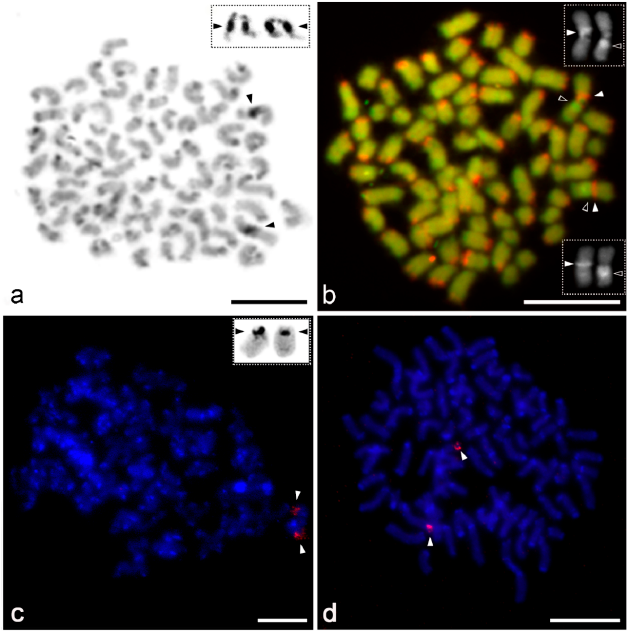
Figure 5. Male chromosomes of Charinus species after chromosome banding techniques ( a , b ) or 18S rDNA FISH ( c , d ). ( a , b , d ) Mitotic metaphase; ( c ) meiotic prophase I, early diplotene. ( a–c ) C. neocal- edonicus. ( a ) C-banding (Giemsa-stained). Note a prominent (peri)centromeric block of constitutive heterochromatin on chromosomes of a large chromosome pair (arrowheads). Inset depicts the same chromosome pair from C-banded meiotic metaphase II pointing to its acrocentric morphology. ( b ) Fluorescent banding with two fluorochromes, GC-specific CMA 3 and AT-specific DAPI. For better contrast, pictures were pseudocolored in red for CMA 3 and green for DAPI. Note a large chromo- some pair with a huge block of (peri)centromeric heterochromatin formed by two segments differ- ing in affinity to applied fluorochromes; CMA 3+ band (full arrow) vs. DAPI + band (empty arrow). Boxes: CMA 3 (left) and DAPI staining (right) of particular chromosomes of the pair. ( c) Chromoso-